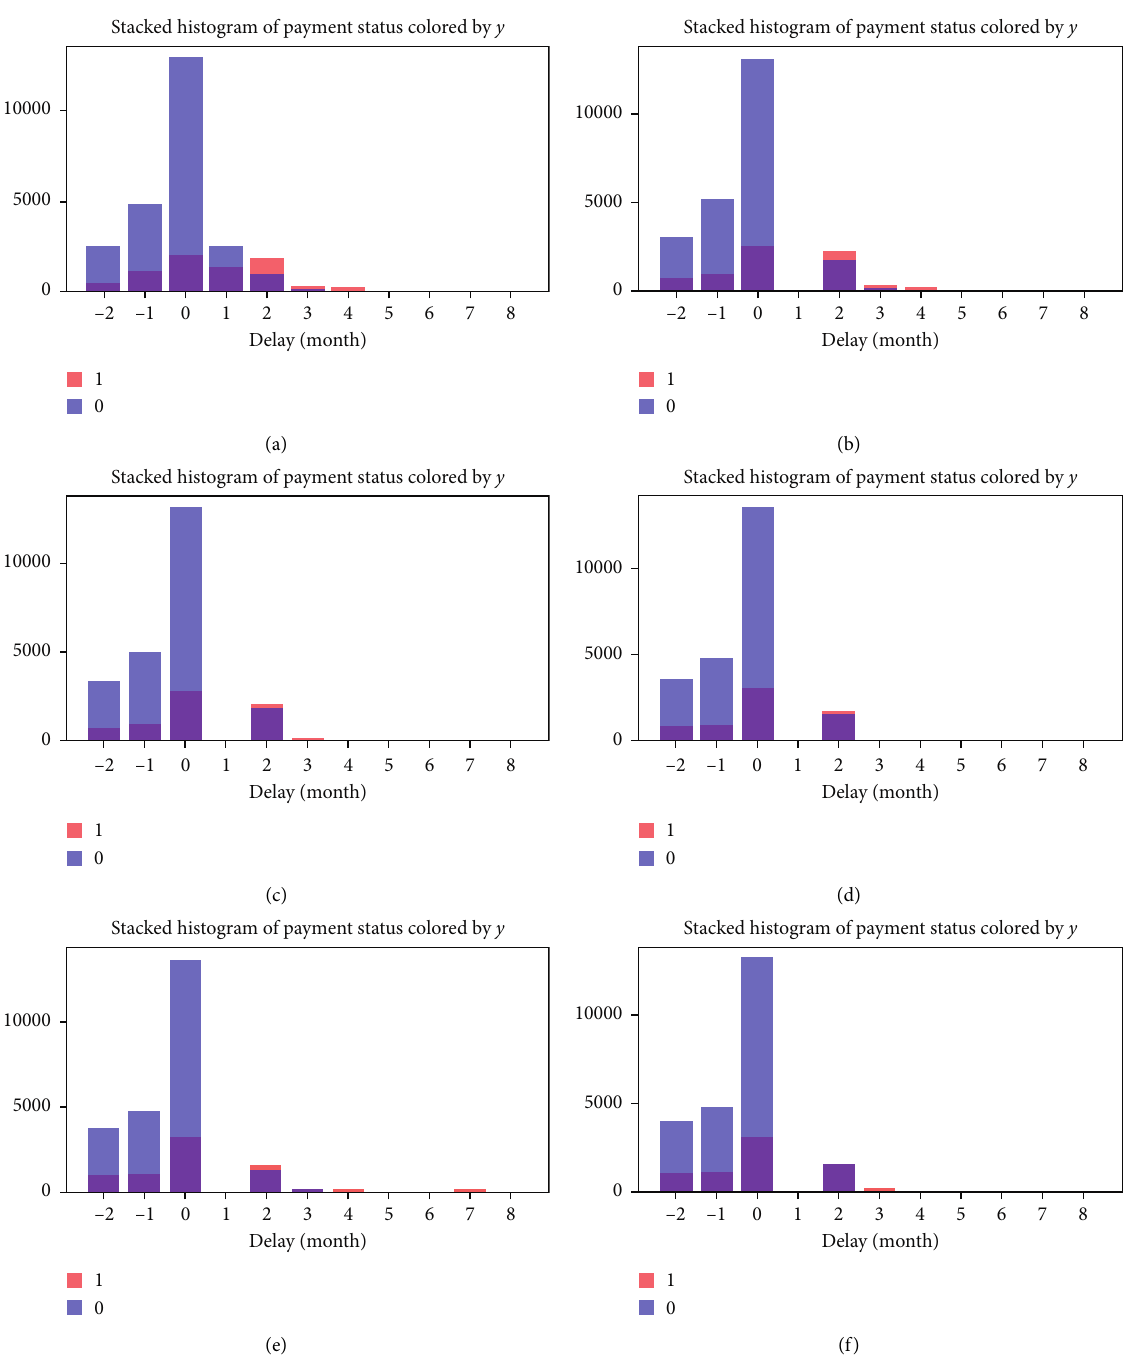
Figure 7: Stacked histogram of payment status. (a) Payment status in September. (b) Payment status in August. (c) Payment status in July. (d) Payment status in June. (e) Payment status in May. (f) Payment status in